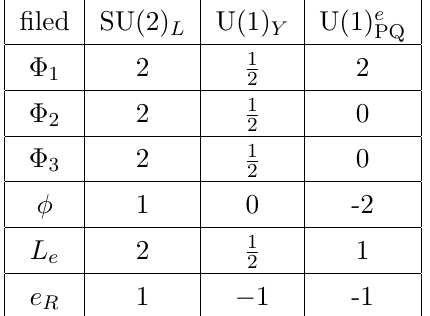
Table 3 . The particles under SU(2) L symmetry. The Higgs doublet (cid:8) 1 and (cid:8) 3 are supposed to be heavy degrees of freedom, which are integrated out in the e(cid:11)ective theory. The mixing between the scalars are assumed to be small and (cid:8) 2 will be the SM-like Higgs.